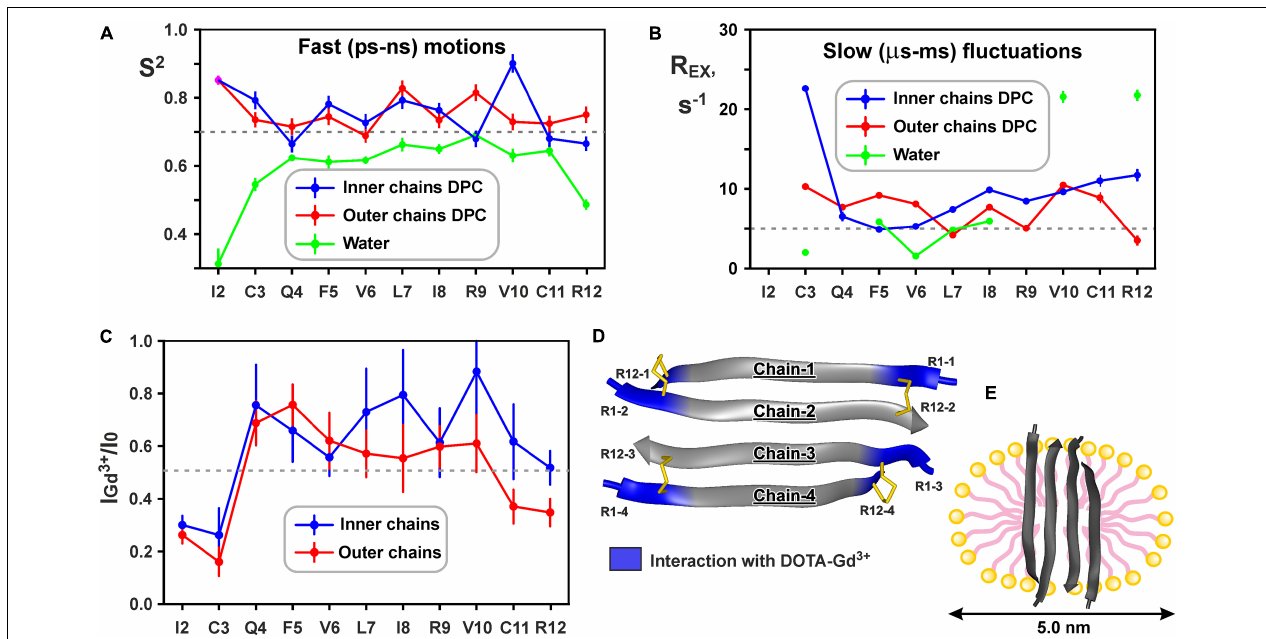
FIGURE 6 | Changes in backbone dynamics of ChDode upon incorporation into DPC micelle and dimerization and topology of the ChDode/DPC micelle complex. (A) The values of generalized order parameters ( S 2 ) calculated during ‘model-free’ analysis of 15 N relaxation data. The S 2 values correspond to amplitude of motions at ps-ns timescale. The lower S 2 value, the greater amplitude of motions. Residues displaying S 2 < 0.7 are subjected to extensive motions in ps-ns timescale. In relaxation spectra the 1 H- 15 N signals of Ile2 residues from inner and outer chains in DPC micelles were overlapped. (B) The values of exchange contributions to the R 2 relaxation rates ( R EX ). The non-zero R EX values (cut-off value of 5 s - 1 is shown) indicate motions at µ s-ms timescale. (C) Attenuation of the HN cross-peaks in the 15 N-HSQC spectrum of the ChDode tetramer by water-soluble paramagnetic DOTA-Gd 3 + complexes. The 0.5 threshold line subdivides data points in two groups: the points below the line corresponds to residues with HN-groups accessible to solvent, the points above the line corresponds to HN-groups shielded from the paramagnetic probe in the micelle interior. (D) Data mapped on the structure of the ChDode tetramer. (E) Proposed model of the ChDode/DPC